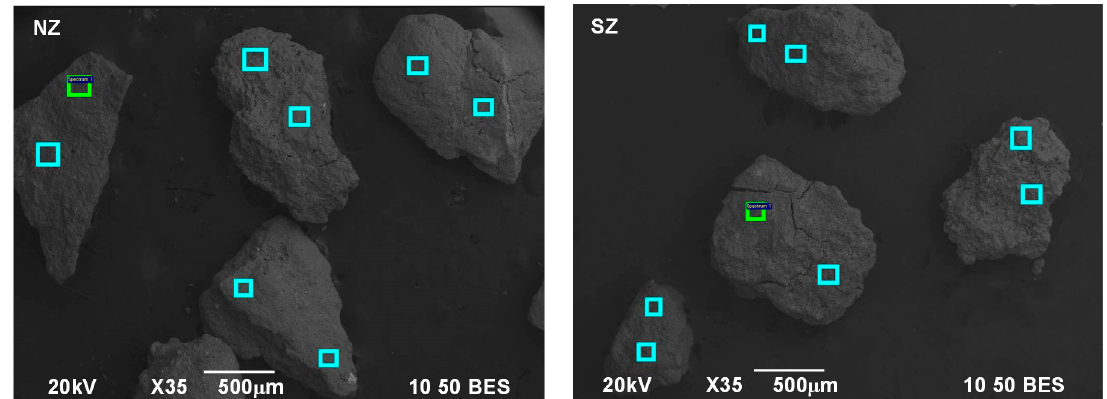
Figure 4. Backscattered electron mode (BSE) images of NZ (left) and SZ (right) with marked eight fields (spectra, Sp) per sample for EDS analysis. Table 5. Semi-quantitative chemical composition (given in wt %) of the eight analyzed fields on the NZ sample (spectra, Sp; analyzed with